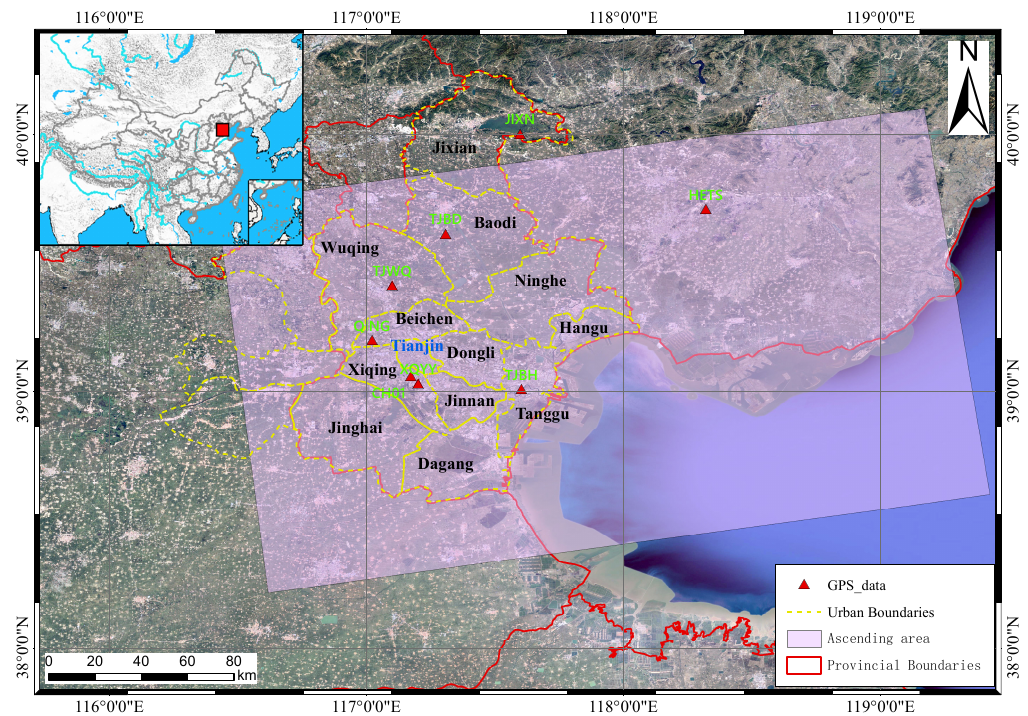
Figure 1. This satellite image shows the location of the study area in our research and the red line is the provincial boundary. The pink rectangular frame denotes the coverage of the Sentinel-1A image and the red triangles represent the distribution of GPS